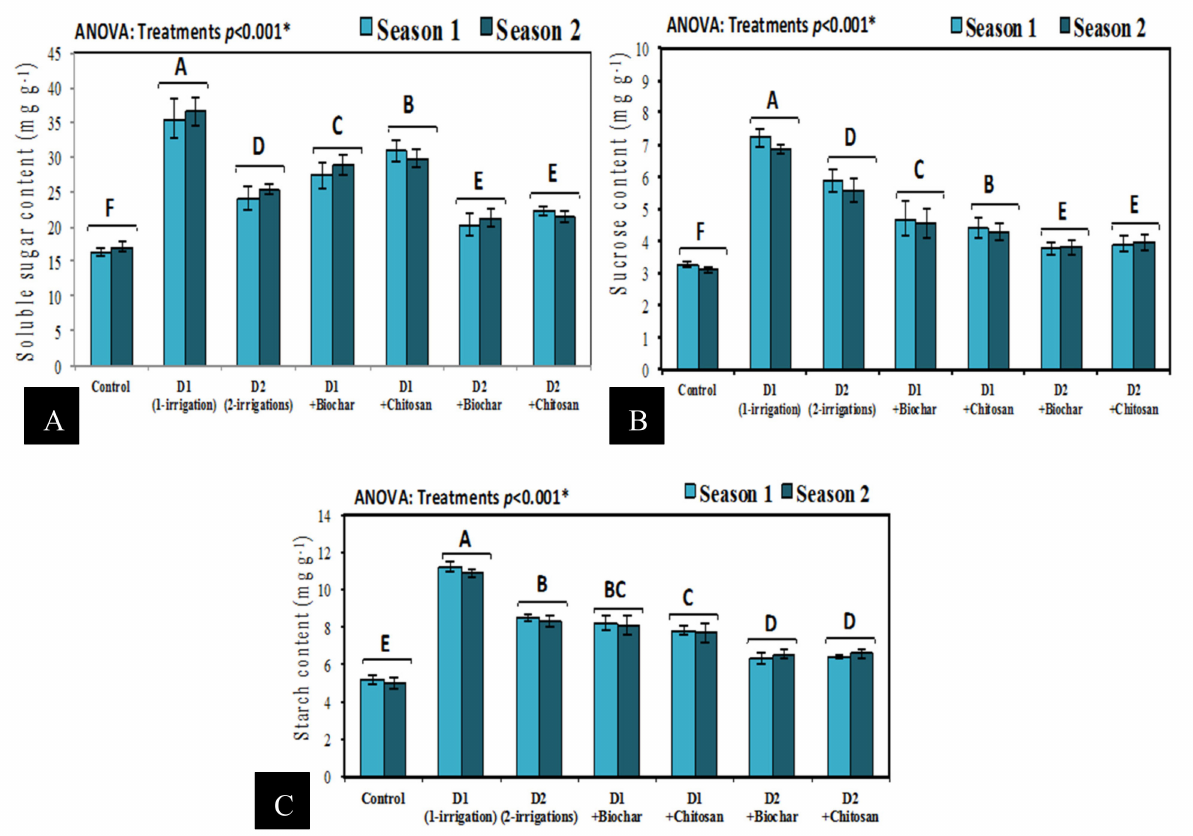
Figure 3. E ff ect of biochar and chitosan on soluble sugars ( A ), sucrose ( B ), and starch contents ( C ) of barley during two seasons (2017 / 2018–2018 / 2019). Bars followed by di ff erent letters are significantly di ff erent at p <